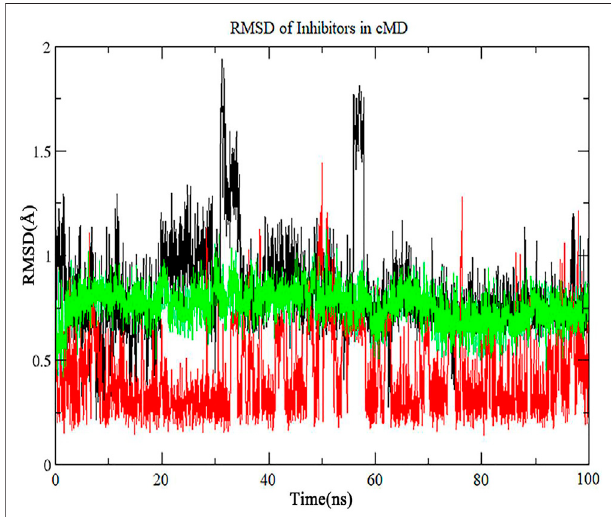
FIGURE 9 | The RMSD of inhibitor No. 07, 15, 18 in extended conventional MD simulation. The line with black, red, green color is inhibitor No. 07, 15, 18 respectively.